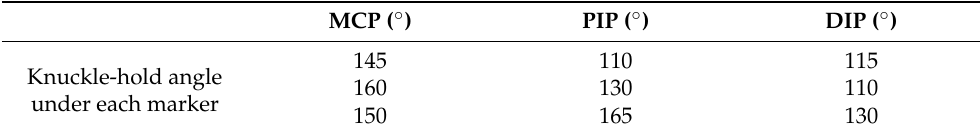
Table 2. Knuckle-retention angles under different markers in different